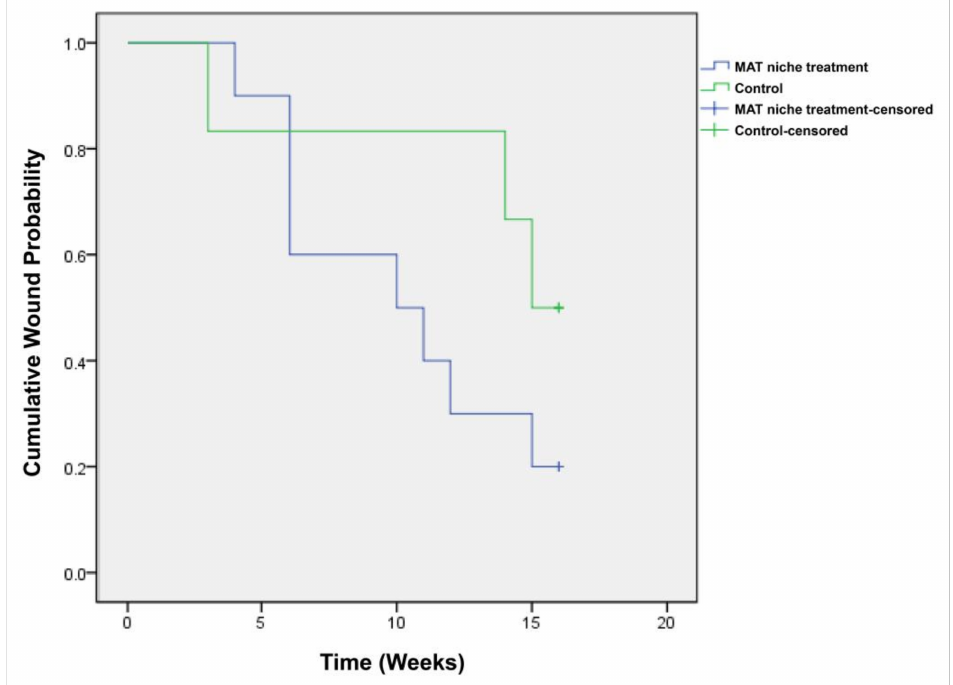
Figure 7. Kaplan–Meier diagram showing results of the time to wound closure. The Kaplan–Meier median times to complete closure were 10.2 ± 1.4 and 13.3 ± 1.9 weeks in the treatment and control groups,